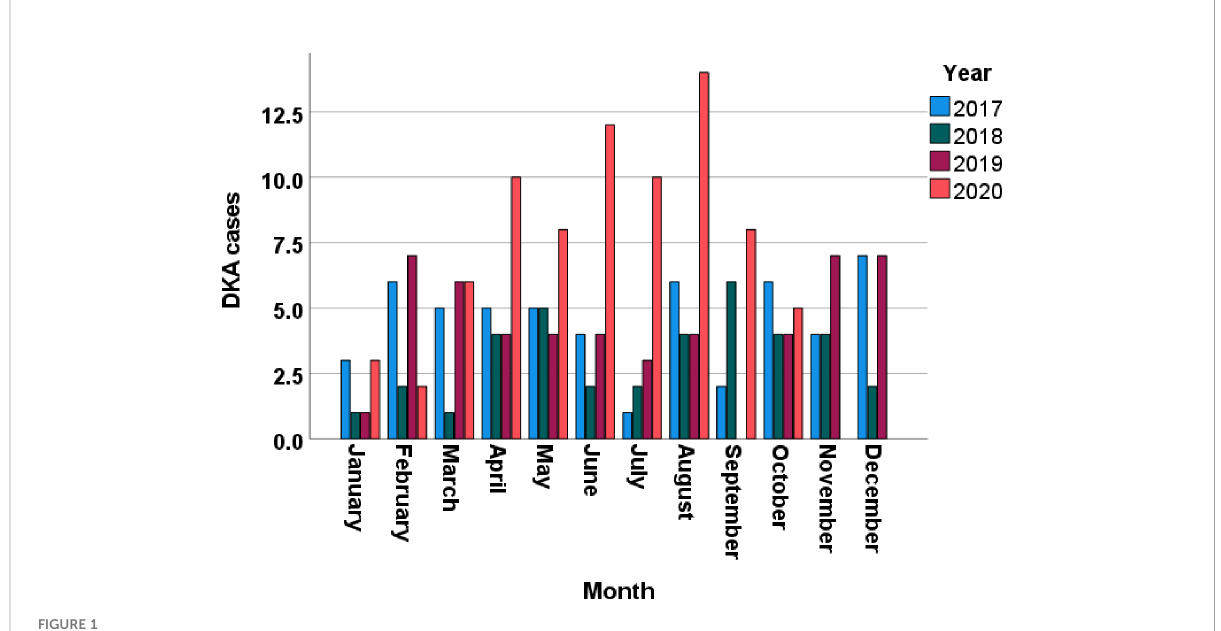
FIGURE 1 DKA cases per month between January 2017 and October 2020.